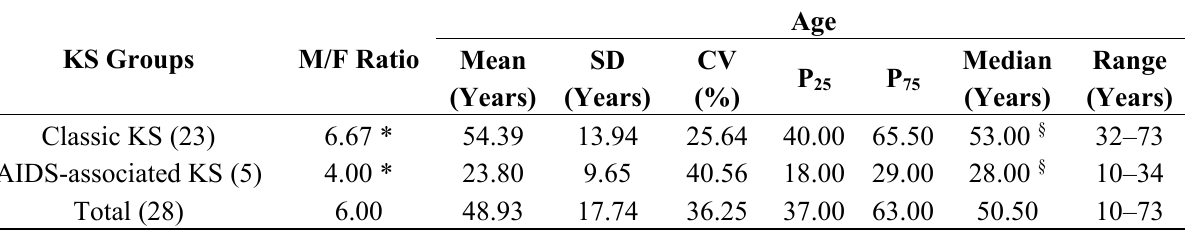
Table 1. Sex and age for KS patients